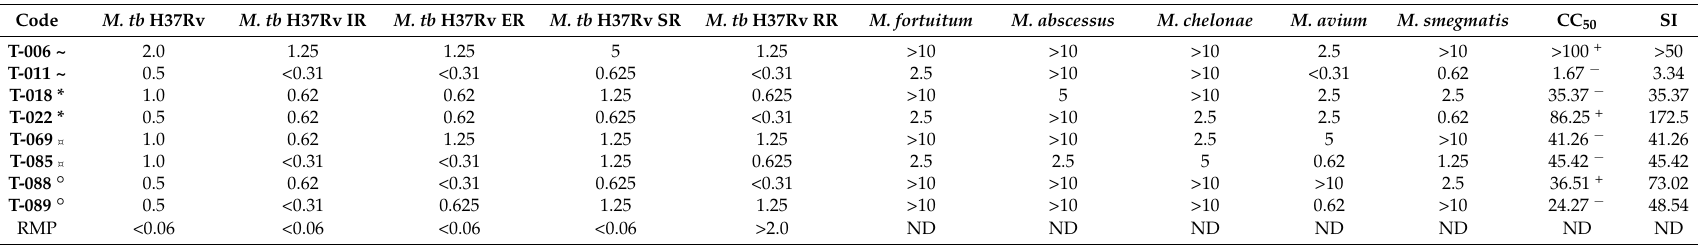
Table 4. Minimum inhibitory concentration (MIC in µ g/mL) of esters of quinoxaline 1,4-di- N -oxide derivatives on monoresistant M. tuberculosis and some nontuberculous Mycobacterium strains.